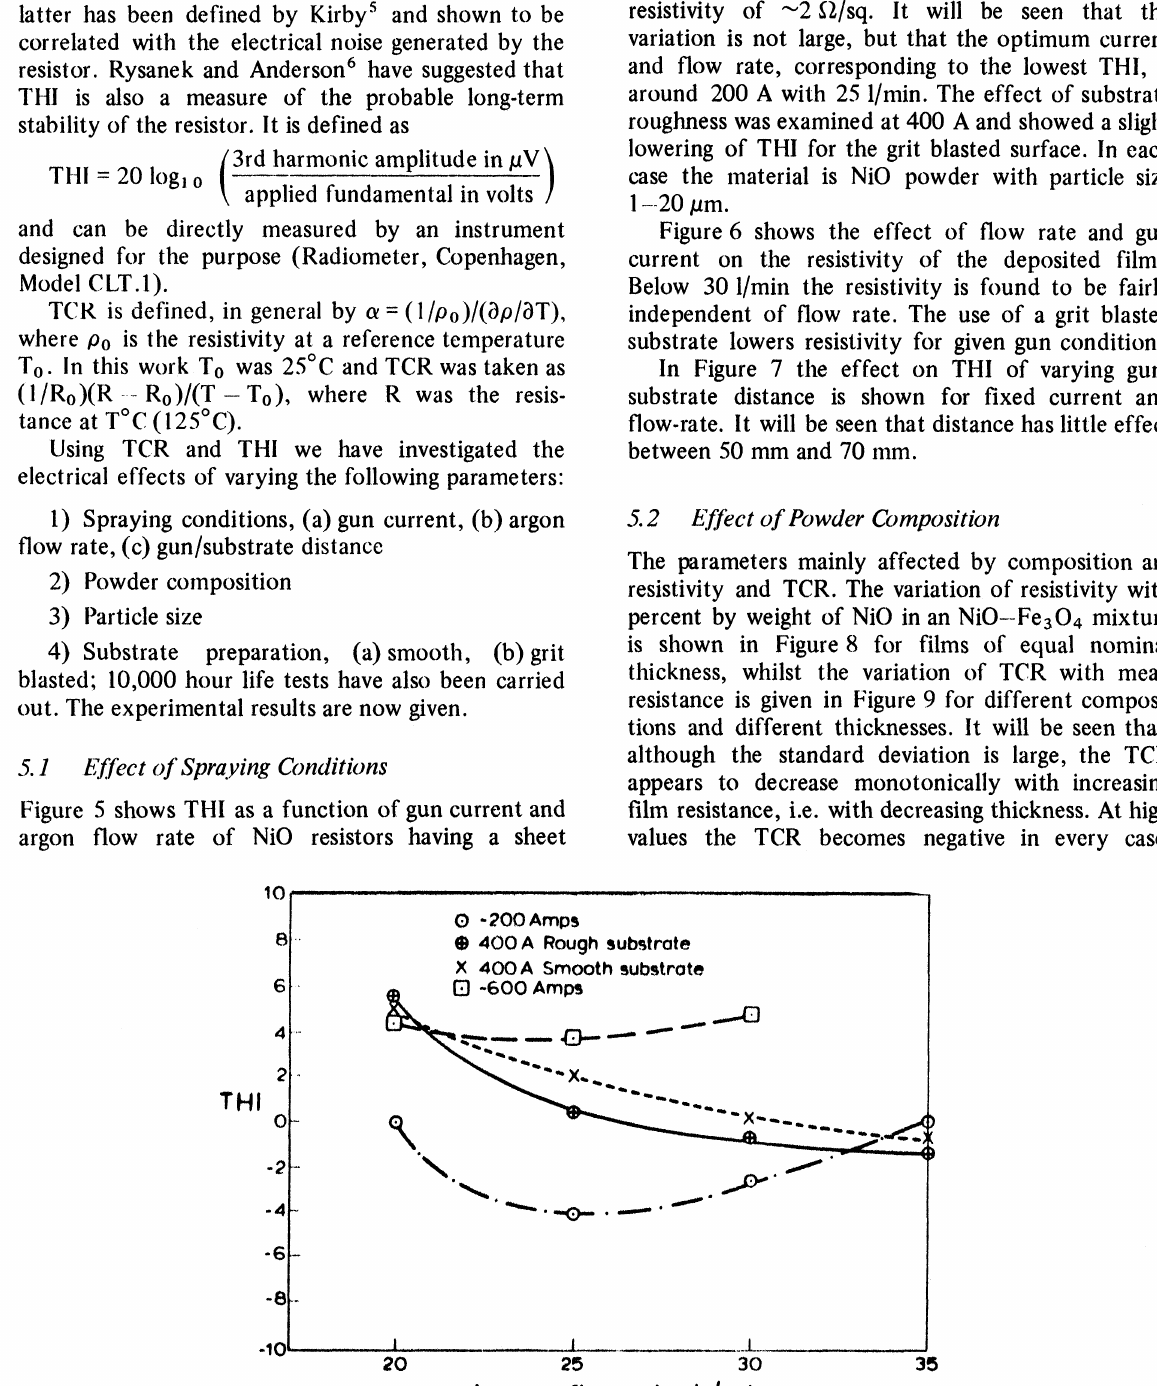
TH! as a function of flow rate and un current on mooth and rit-blatcd ubtratc. powder, sheet resistivity 4